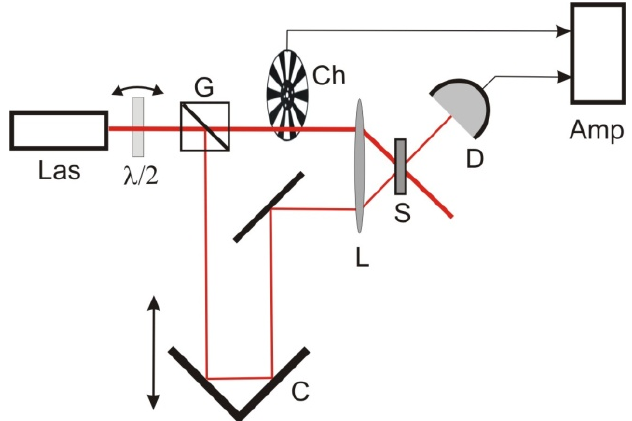
Figure 2. Schematics of the pump-probe setup for frequency-degenerate differential transmission (DT) measurements.